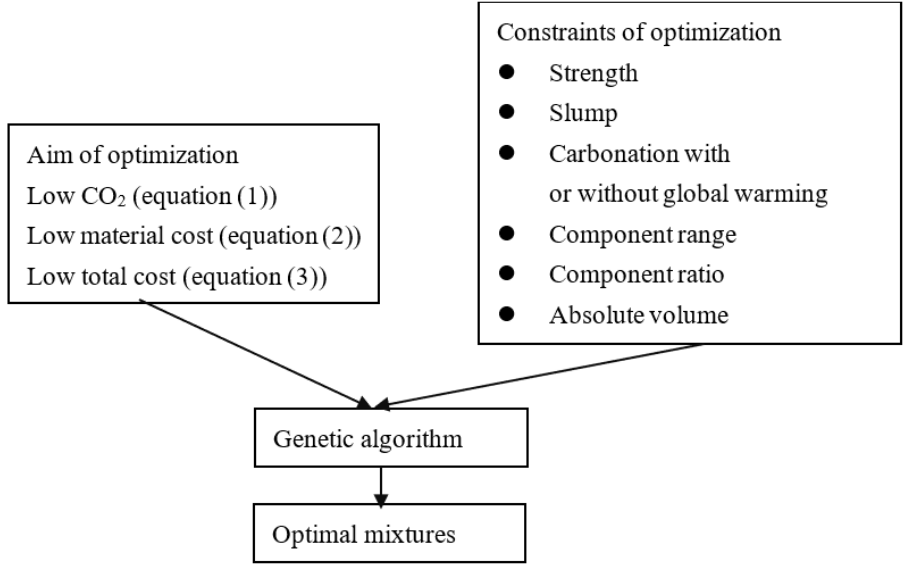
Figure 1. Framework of optimal design.